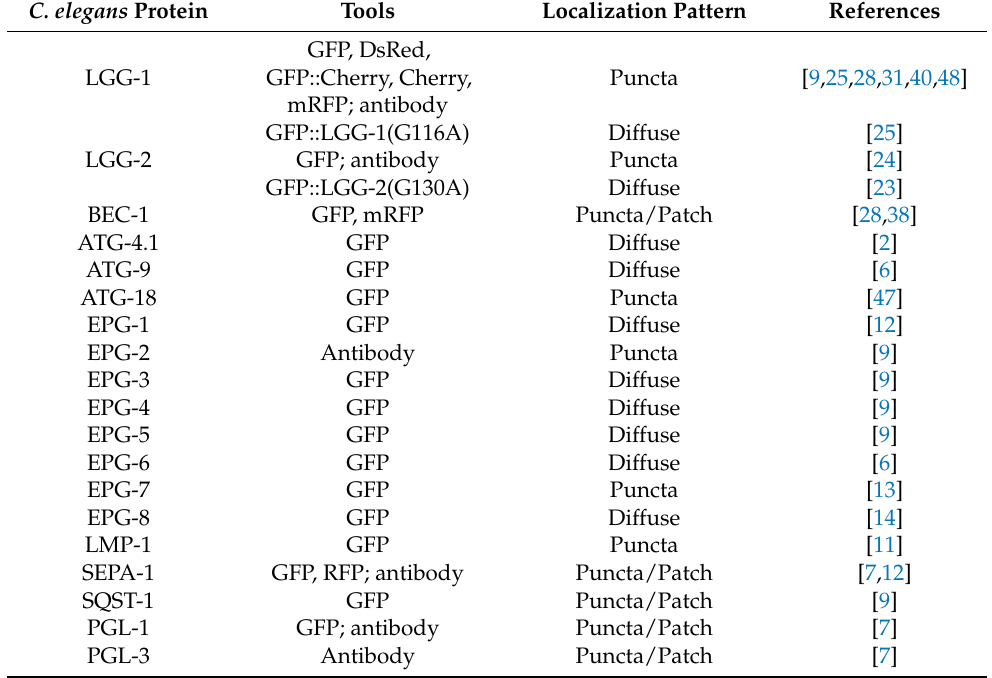
Table 2. List of autophagic reporters and targets of antibodies in C. elegans . Tools Localization